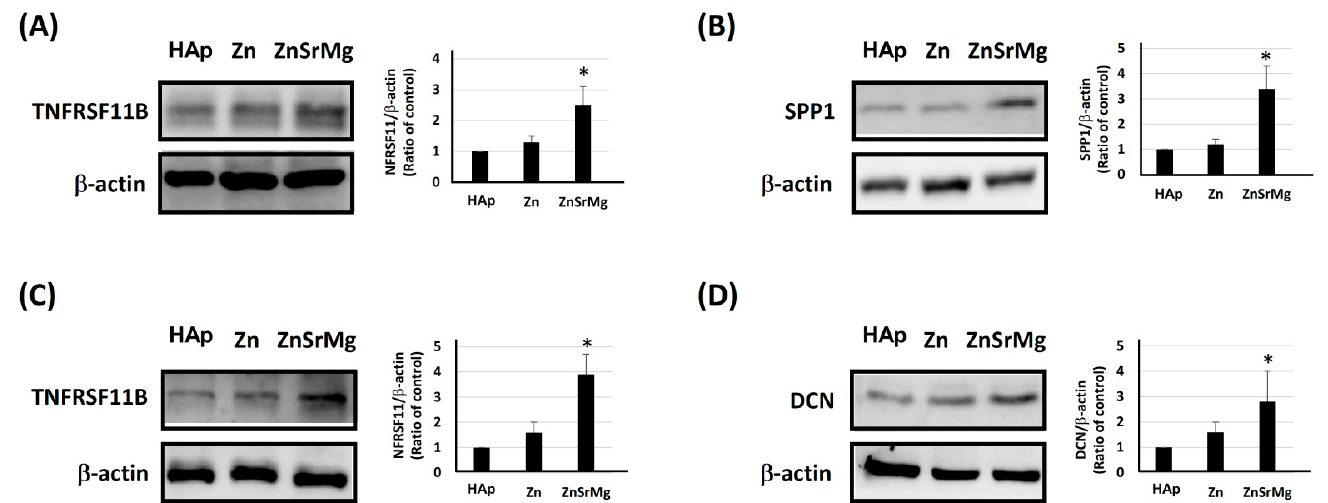
Figure 2. Expression of osteointegration-associated proteins in HEPM. The HEPM cells were incu- bated on titanium discs coated with HAp, Zn-HAp, or ZnSrMg-HAp for 7 ( A , B ) and 11 days ( C , D ). The cellular lysate was used for a Western blot assay with antibodies of TNFRSF11B ( A , C ), SPP1 ( B ), DCN ( D ), and β -actin ( A – D ). * p < 0.05 vs. HAp group.